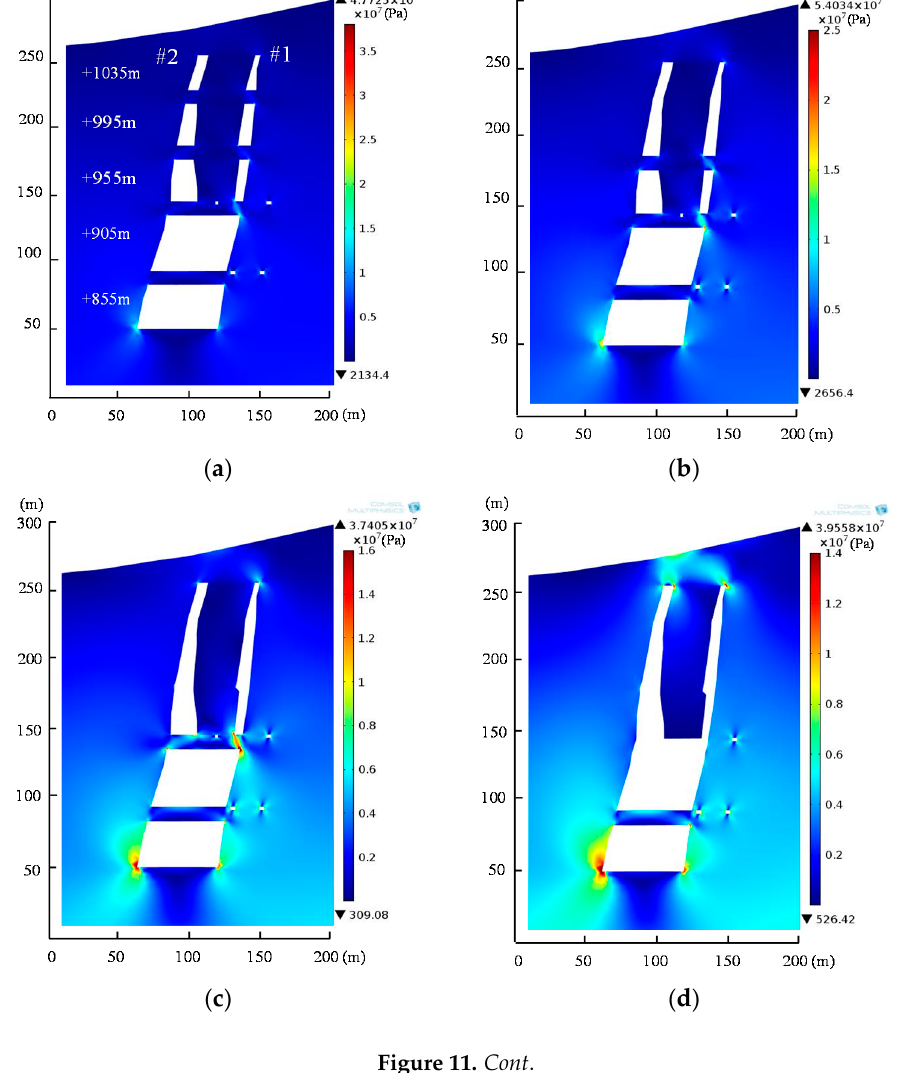
( e ) Figure 11. The surrounding rock failure mechanism in top-down mining process: ( a ) recovery of the +1035 m level, #1 and #2 represent the ore body number; ( b ) recovery of the +995 m level; ( c ) recovery of the +955 m level; ( d ) recovery of the +905 m level; ( e ) recovery of the +855 m level.